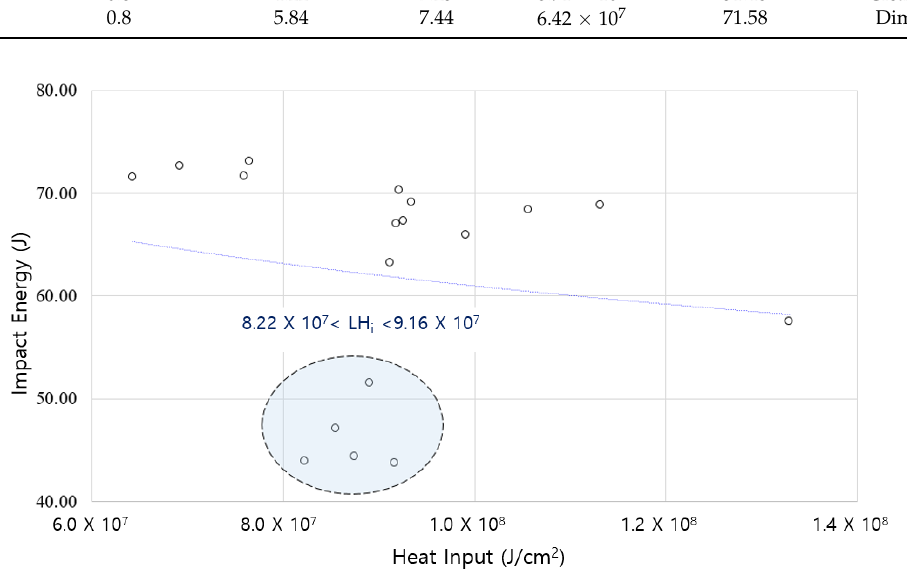
Figure 7. Impact energy distributions according to heat input in fiber laser welding. The criterion for the amount of heat input, i.e., (8.22 × 10 7 ~9.16 × 10 7 ) J/cm 2 , of